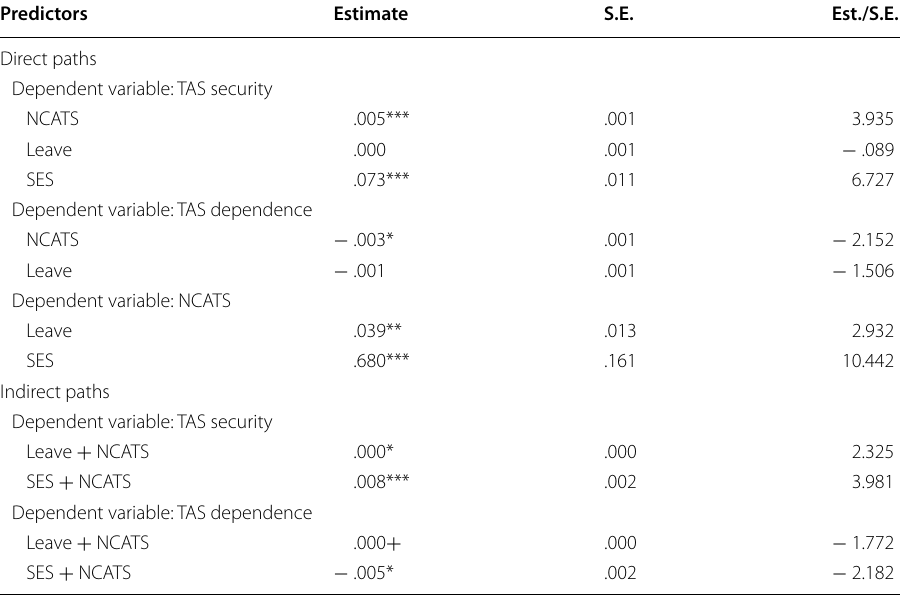
Table 3 Decomposition of effect, direct and indirect